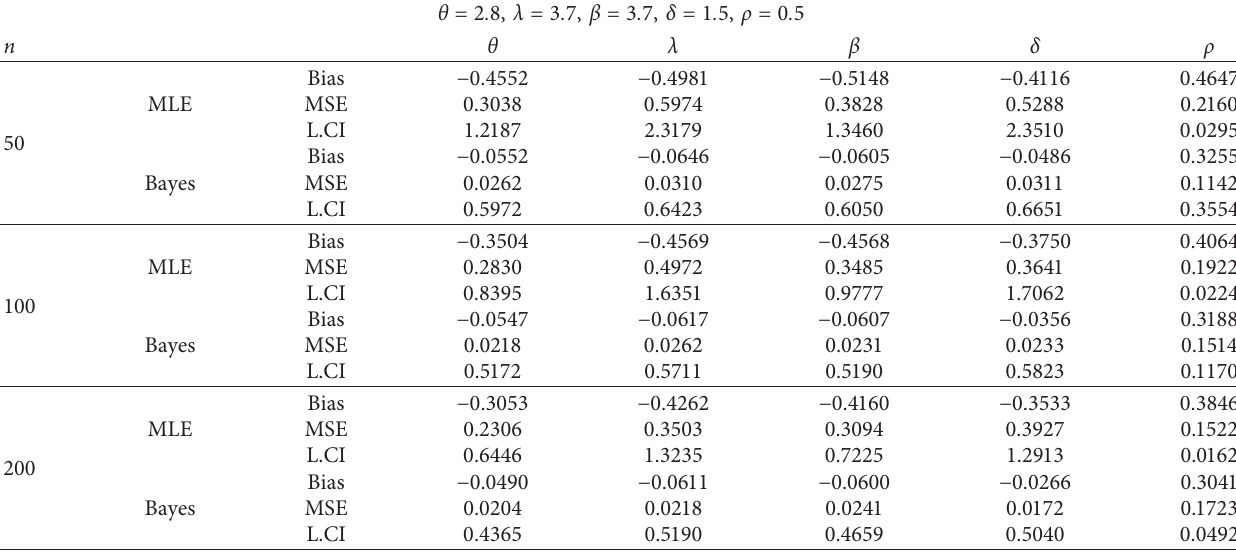
Table 2: MLE and Bayesian estimation with different sample sizes in the independent case.